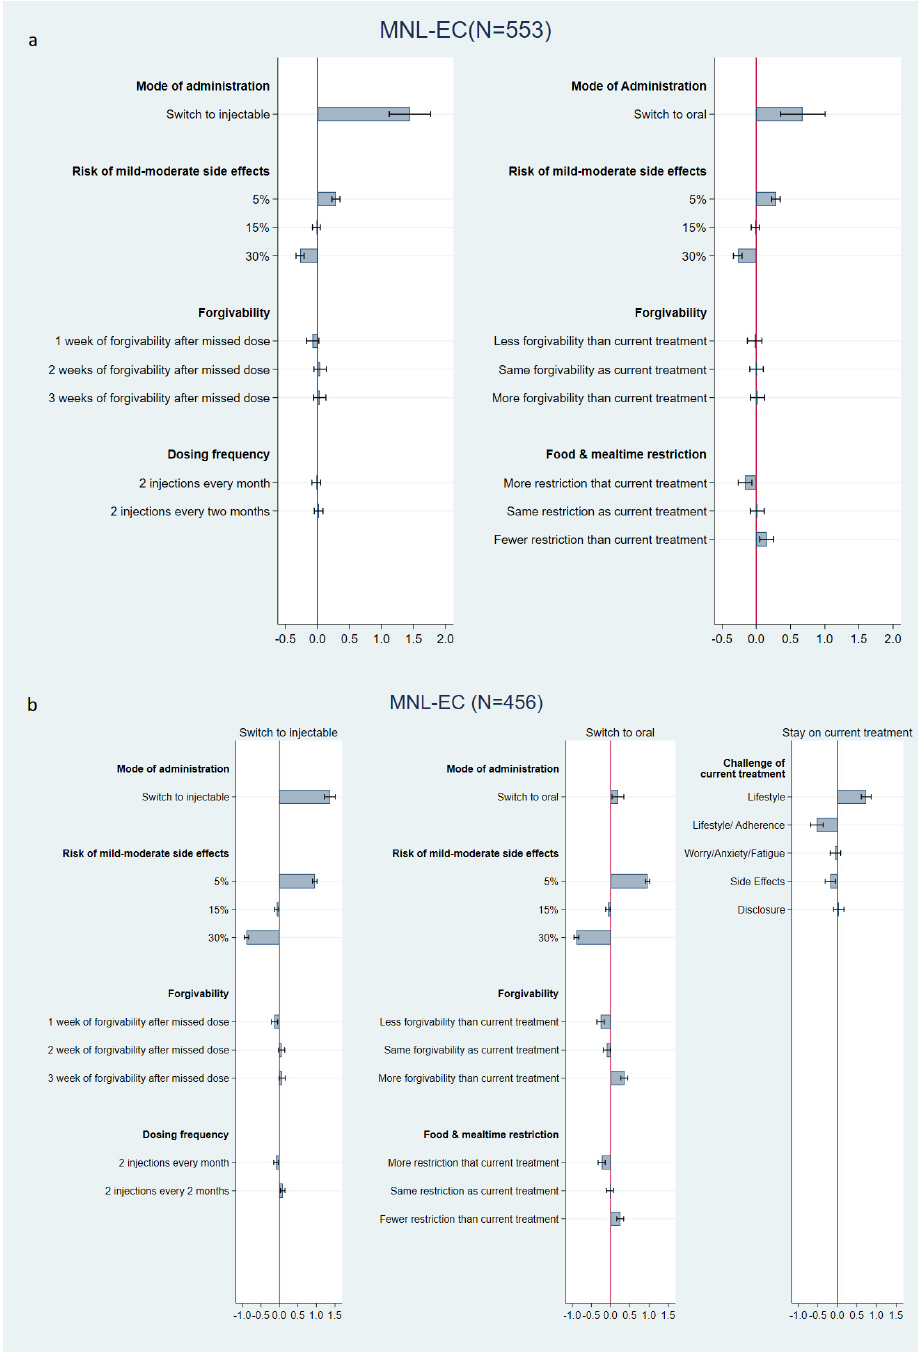
Figure 2. ( a ) Estimated marginal utilities: PLWH (N = 553). ( b ) Estimated marginal utilities: physi- cians (N = 456). PLWH—people living with HIV; SD—standard deviation; *** p < 0.001; PLWH: Final Log-Likelihood = − 4817; Adjusted McFadden R 2 = 0.338; Physicians: Final Log-Likelihood = − 5788; Adjusted McFadden R 2 = 0.276. In Figure 2a, bars to the right of the red line indicate a positive impact on the likelihood of switching to either injectable or a new oral, with longer bars indicating a stronger impact on preference. A statistically significant effect is present if the confidence interval does not overlap with 0. In Figure 2b, bars to the right of the red line indicate a positive impact on the likelihood of recommending a switch to either injectable or a new oral, with longer bars indicating a stronger impact. A statistically significant effect is present if the confidence interval does not overlap with